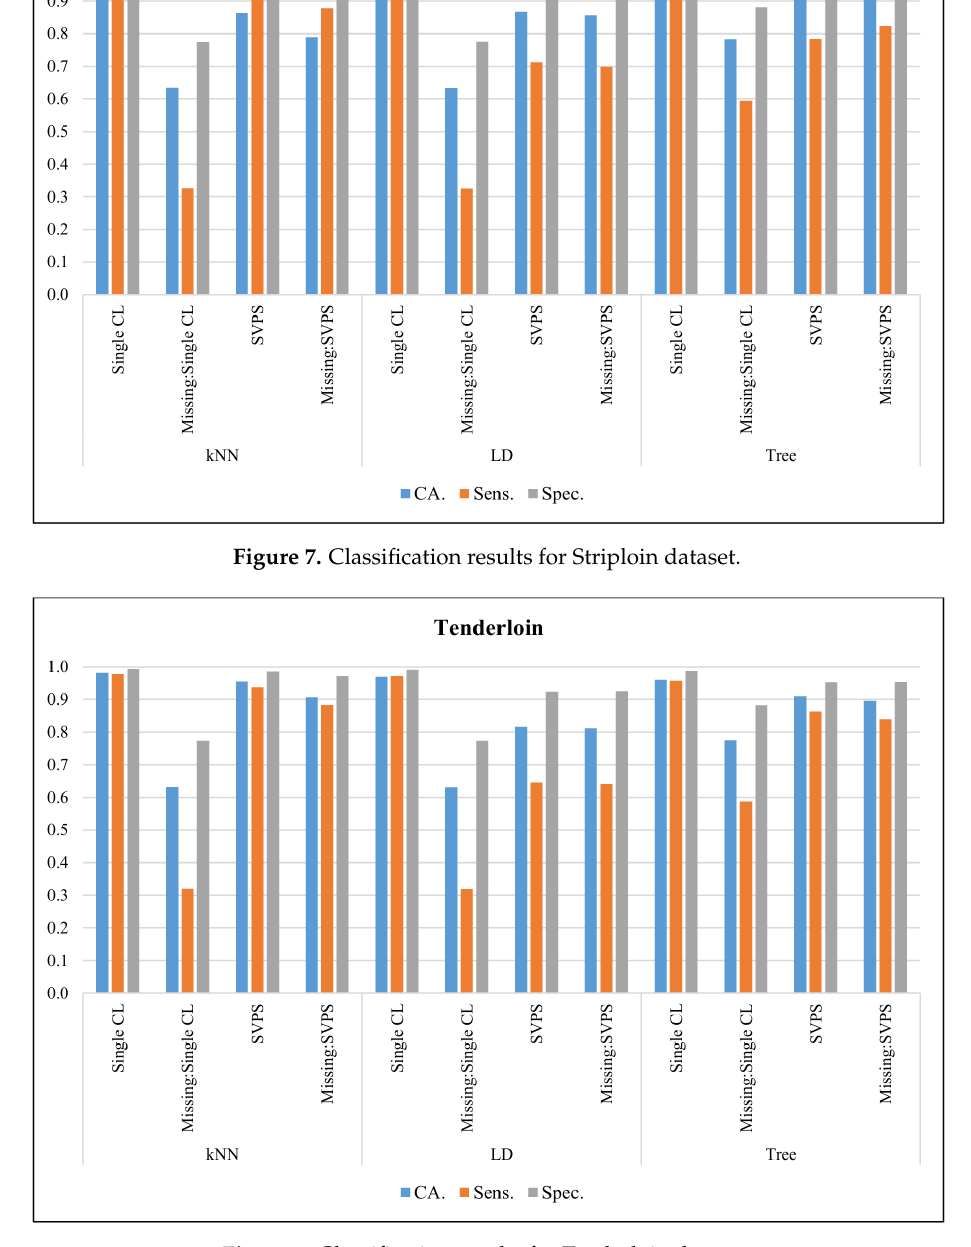
Figure 8. Classification results for Tenderloin